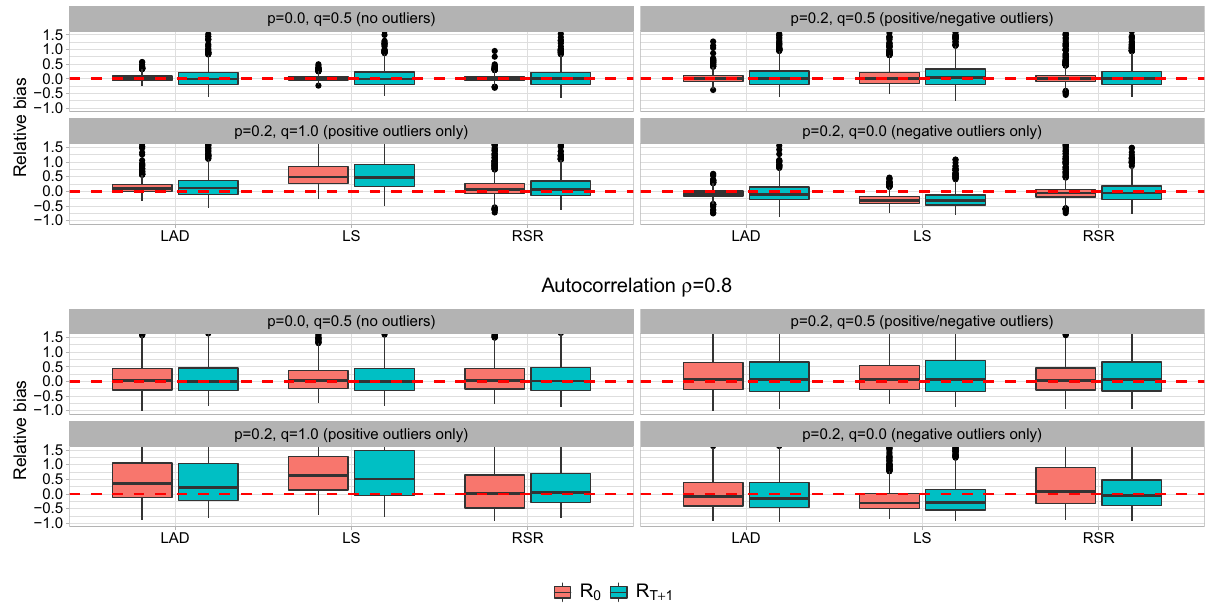
Figure 2. Relative bias of R 0 (the quantity related to the long-term conservation objective) and R T quantity related to the short-term conservation objective) for the simulation using the HS SR function with/ without autocorrelation and outliers in the